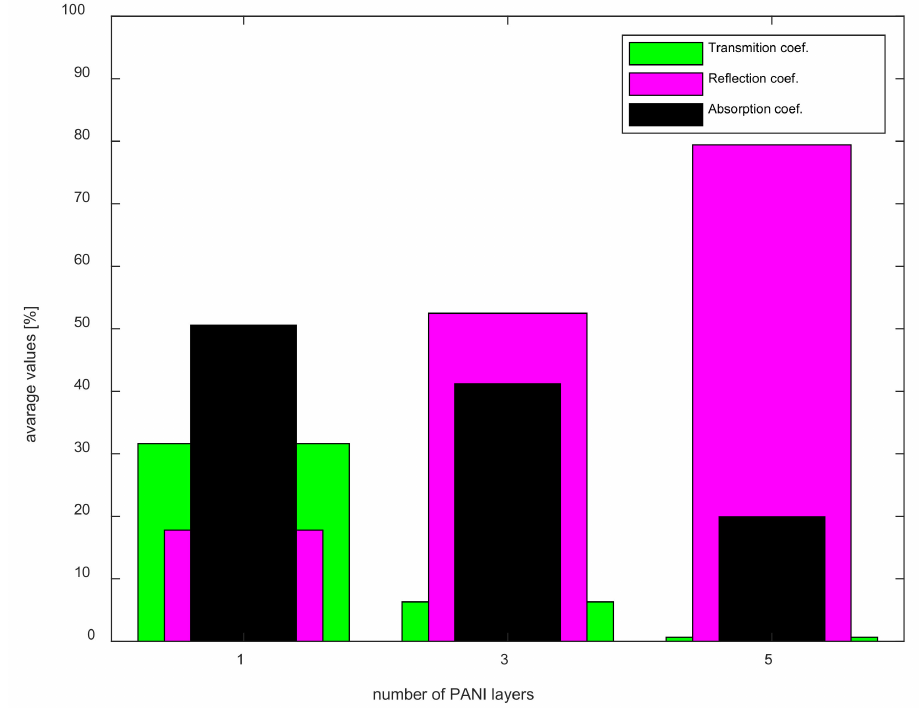
Figure 9. Percentage components of shielding for samples with PANI layers.